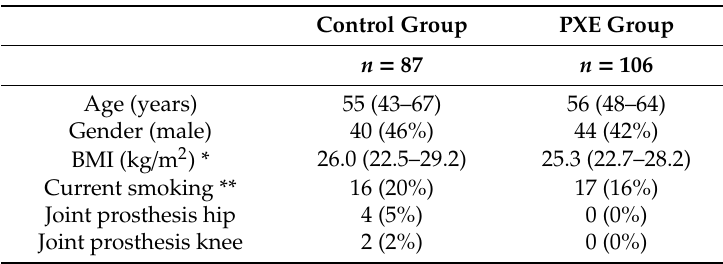
Table 1. Baseline